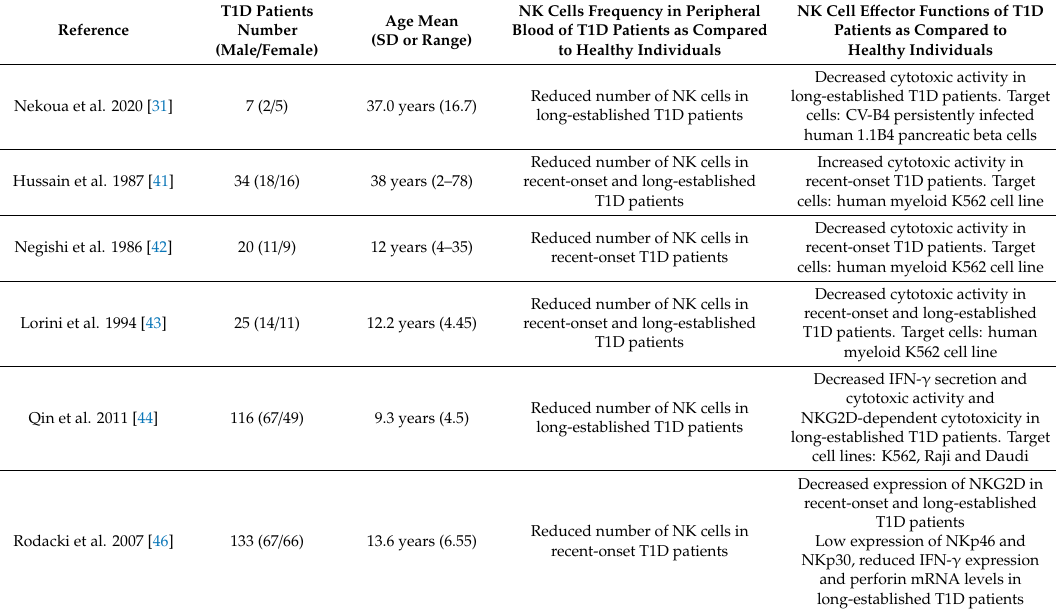
Table 1. Summary of findings of clinical studies on NK cells number and function in patients with T1D compared to healthy